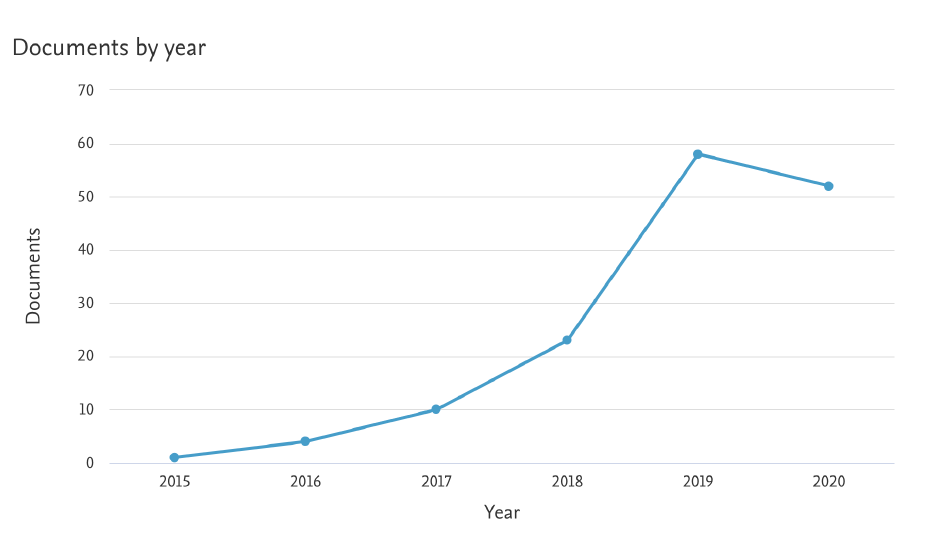
Figure 8. The number of microexpression recognition publications using deep learning in the period 2016–2020 (source: